Question: Write a single sentence explaining what this figure depicts.
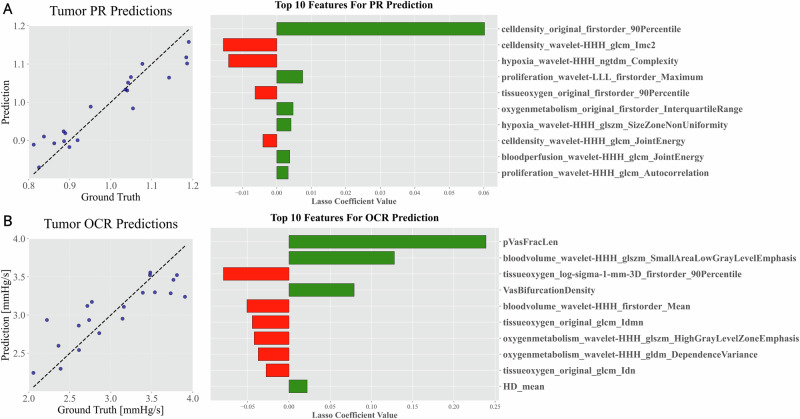
Answer: LASSO-based prediction performance of radiomic features. Prediction performance of proliferation rate (PR, A ) and oxygen consumption rate (OCR, B ) using all extracted radiomic features with a LASSO regression model. The top ten features selected by the LASSO model, ranked by absolute coefficient magnitude, are listed on the right, with coefficient signs indicating the direction of association with the target biological parameter.